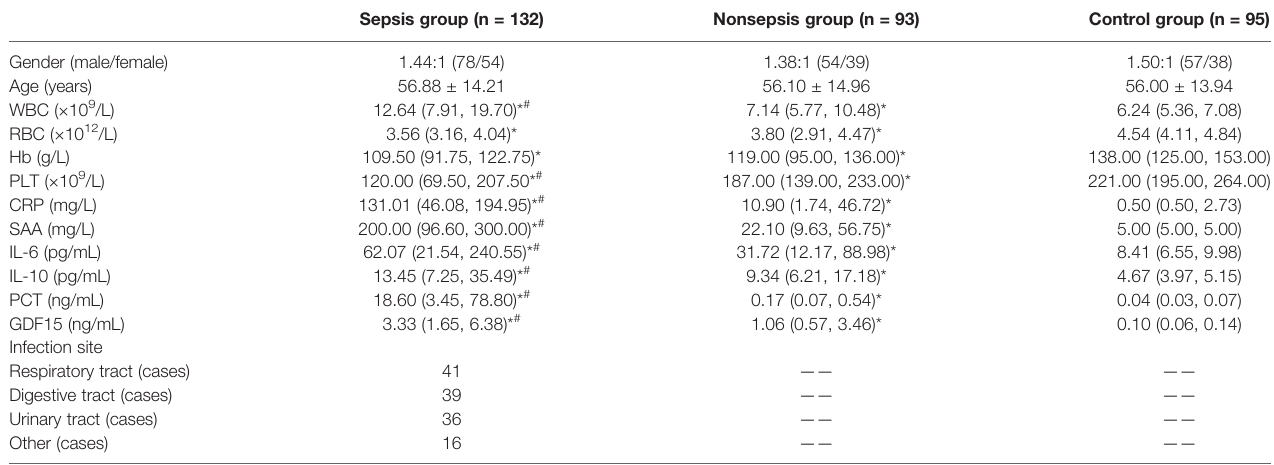
TABLE 1 | Characteristics of the study